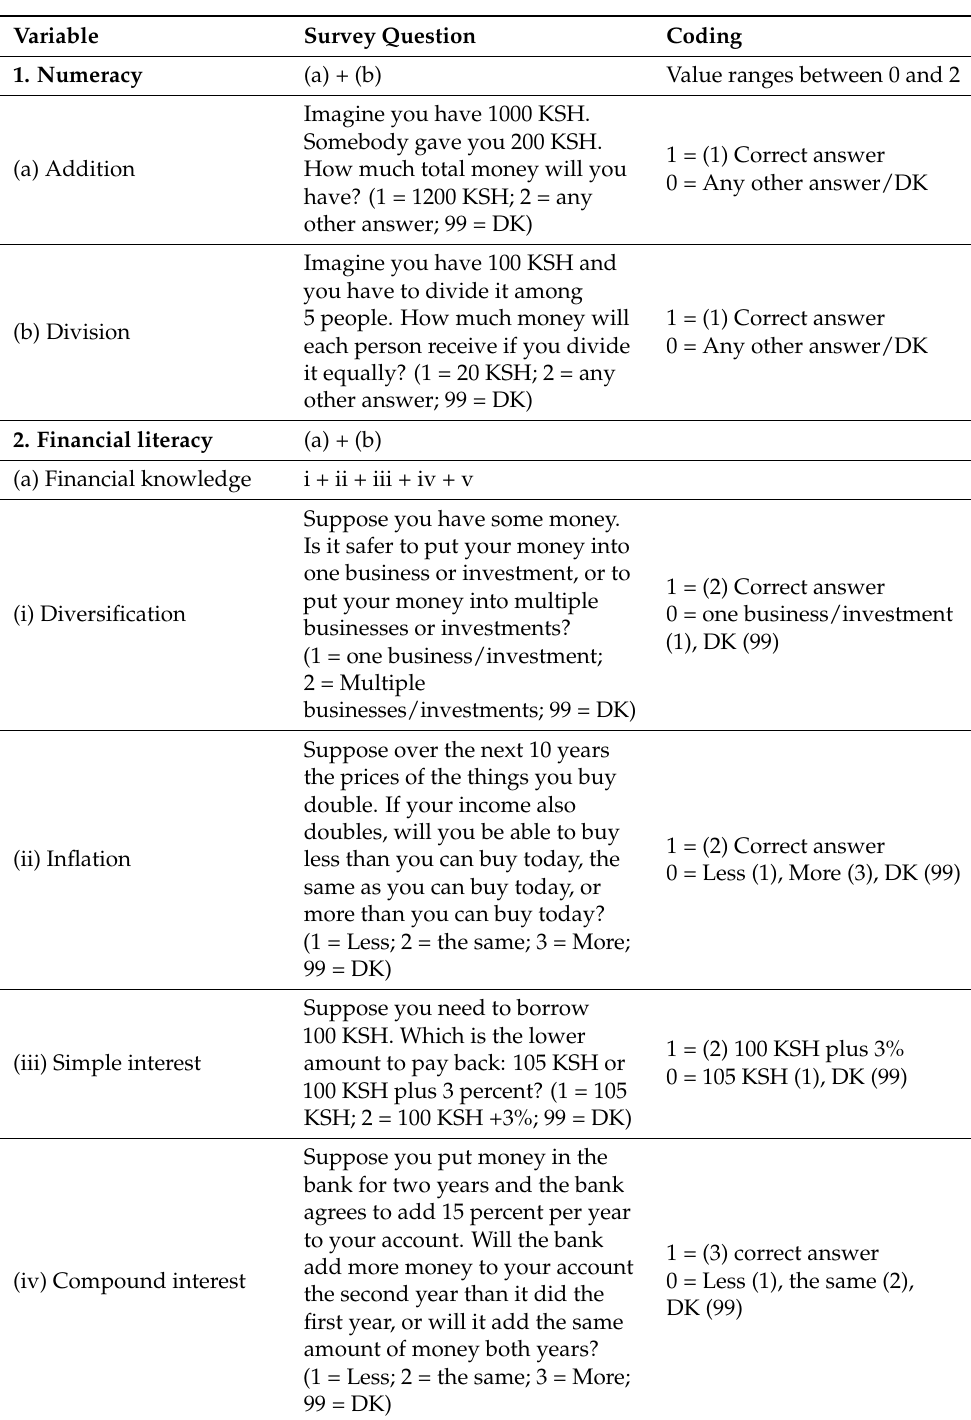
Table A1. Measurement of numeracy, financial literacy and financial